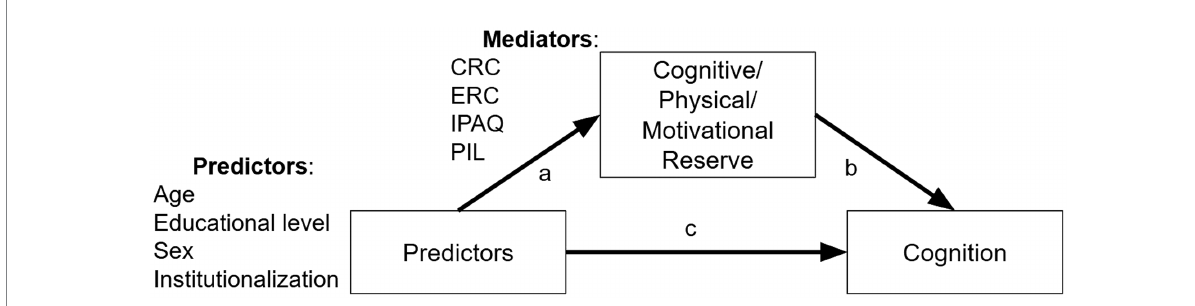
FIGURE 1 Structure of the mediation analyses tested. For each predictor (sociodemographic variables: age, education level, sex, institutionalization), we tested if their effect on cognition (measured with MoCA and M@T) was mediated by cognitive (CRQ, CRS scores), physical (IPAQ scores) and motivational (PIL scores) reserves. MoCA, Montreal Cognitive Assessment; M@T, Memory Alteration Test; CRQ, Cognitive Reserve Questionnaire; CRS, Cognitive Reserve Scale; IPAQ, International Physical Activity Questionnaire; PIL, Purpose in Life